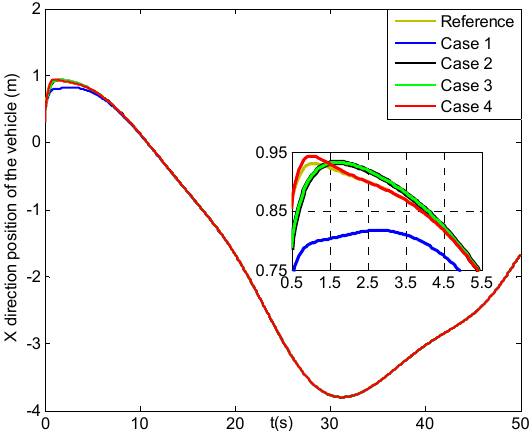
Figure 18. X direction positions of the vehicle (four cases).